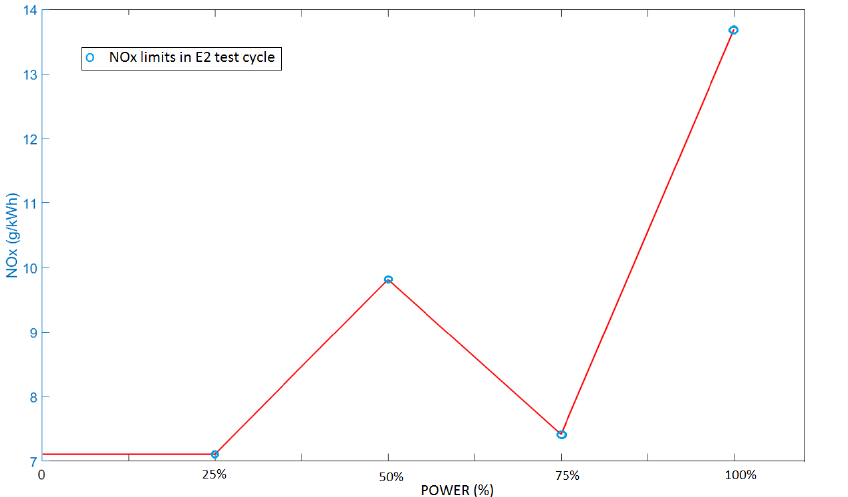
Figure 3. IMO E2 test